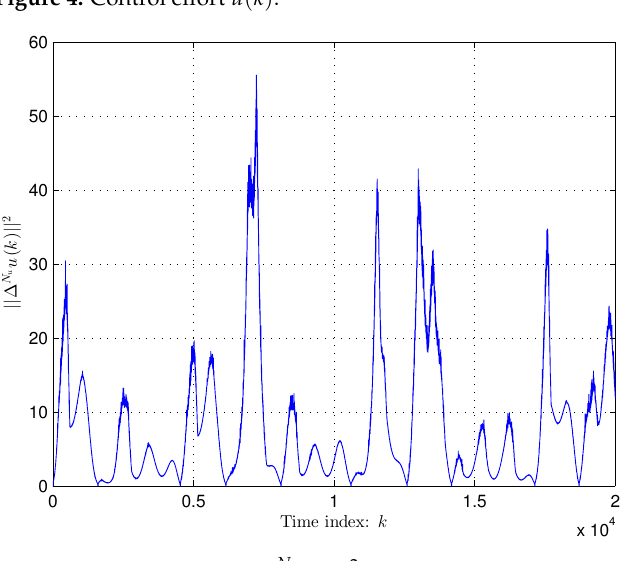
Figure 5. Time varying of | ∆ N u α u ( k ) | 2